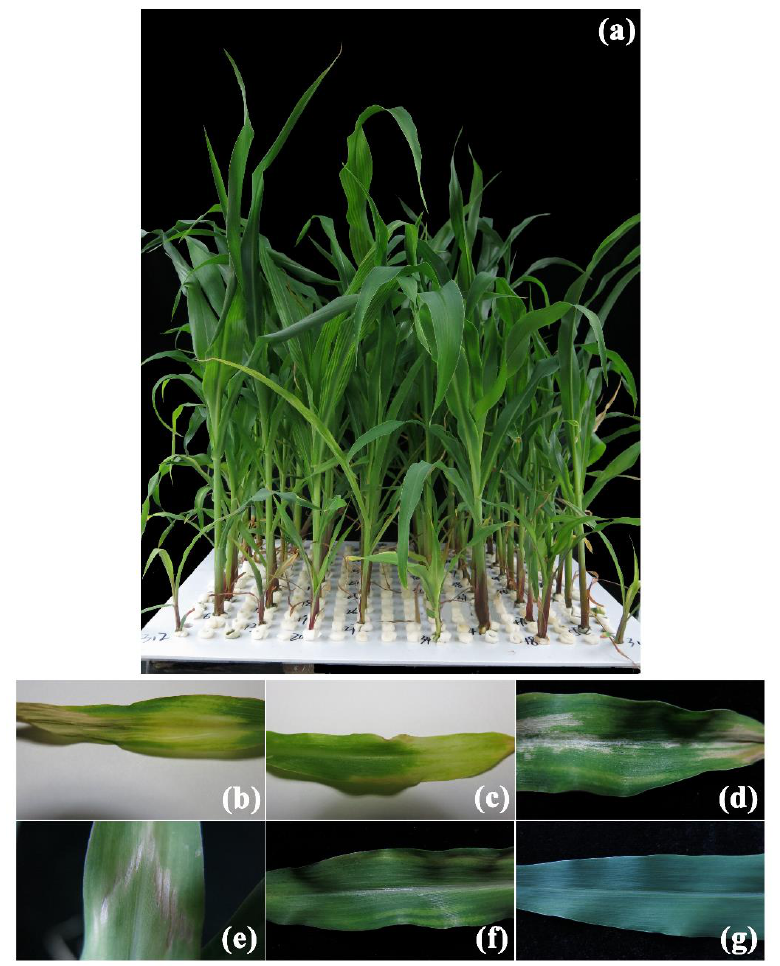
Figure 3. Phenotypic variations in the RILs and six scales for Zn score under Zn deficiency in maize. ( a ) In the -Zn treatment, two plants for each parent and 53 RILs were grown in hydroponics for 21 days after transplanting in each container. Large variations of Zn-deficient symptoms were observed among RILs. Zn score for each plant has been visually recorded for three times since 15th day after transplanting. ( b ) All leaves show wrinkled leaf margins and small malformed leaves, and more than 50% of areas on middle and young leaves show chlorosis and turn pale yellow. The whole leaf with obvious Zn-deficient symptoms tends to be dead with declines in physiological functions. ( c ) Clustering and malformed leaves are prominent symptoms, and 30 – 50% of areas on middle and young leaves show Zn deficient chlorosis with necrotic patches distributed on margins and tips of leaves. ( d ) All leaves are clustering and small leaves, and 20 – 30% of areas on middle and young appear brown patches. Moreover, Zn-deficient chlorosis has been improved compared with plants in score-0 and 1. ( e ) The stretch for all leaves of score-3 plant is strongly inhibited and necrotic spots are shown on 10 – 20% of areas in middle and young leaves. ( f ) There are no obvious differences of score-4 plant between the -Zn and CK treatments. However, banded chlorosis is still shown on leaf margins of middle and young leaves. ( g ) Score-5 plants are green and healthy without any Zn-defi- cient symptoms.